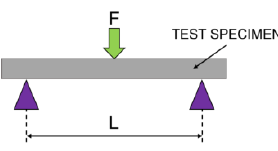
Figure 1. Schematic setup utilized for three-point bending test.